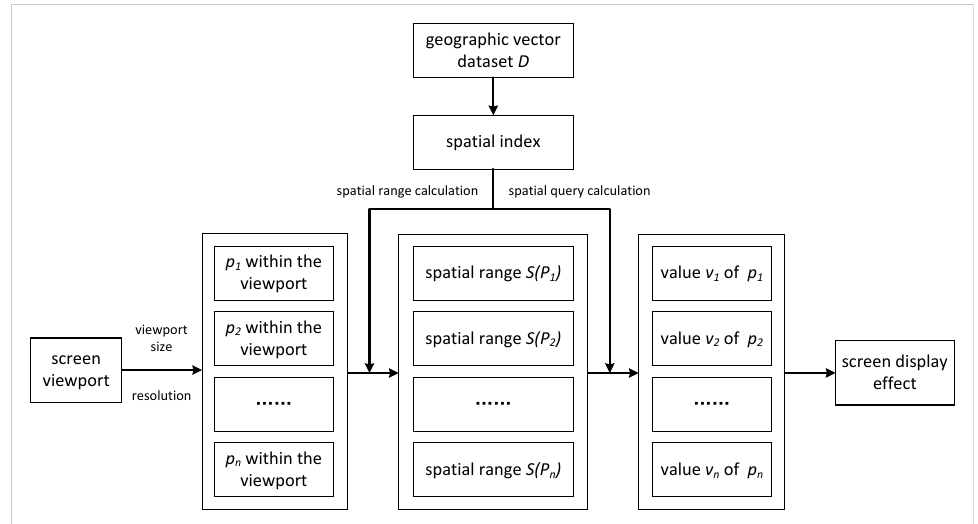
Figure 1. Viewport generalization visualization model of geographic vector